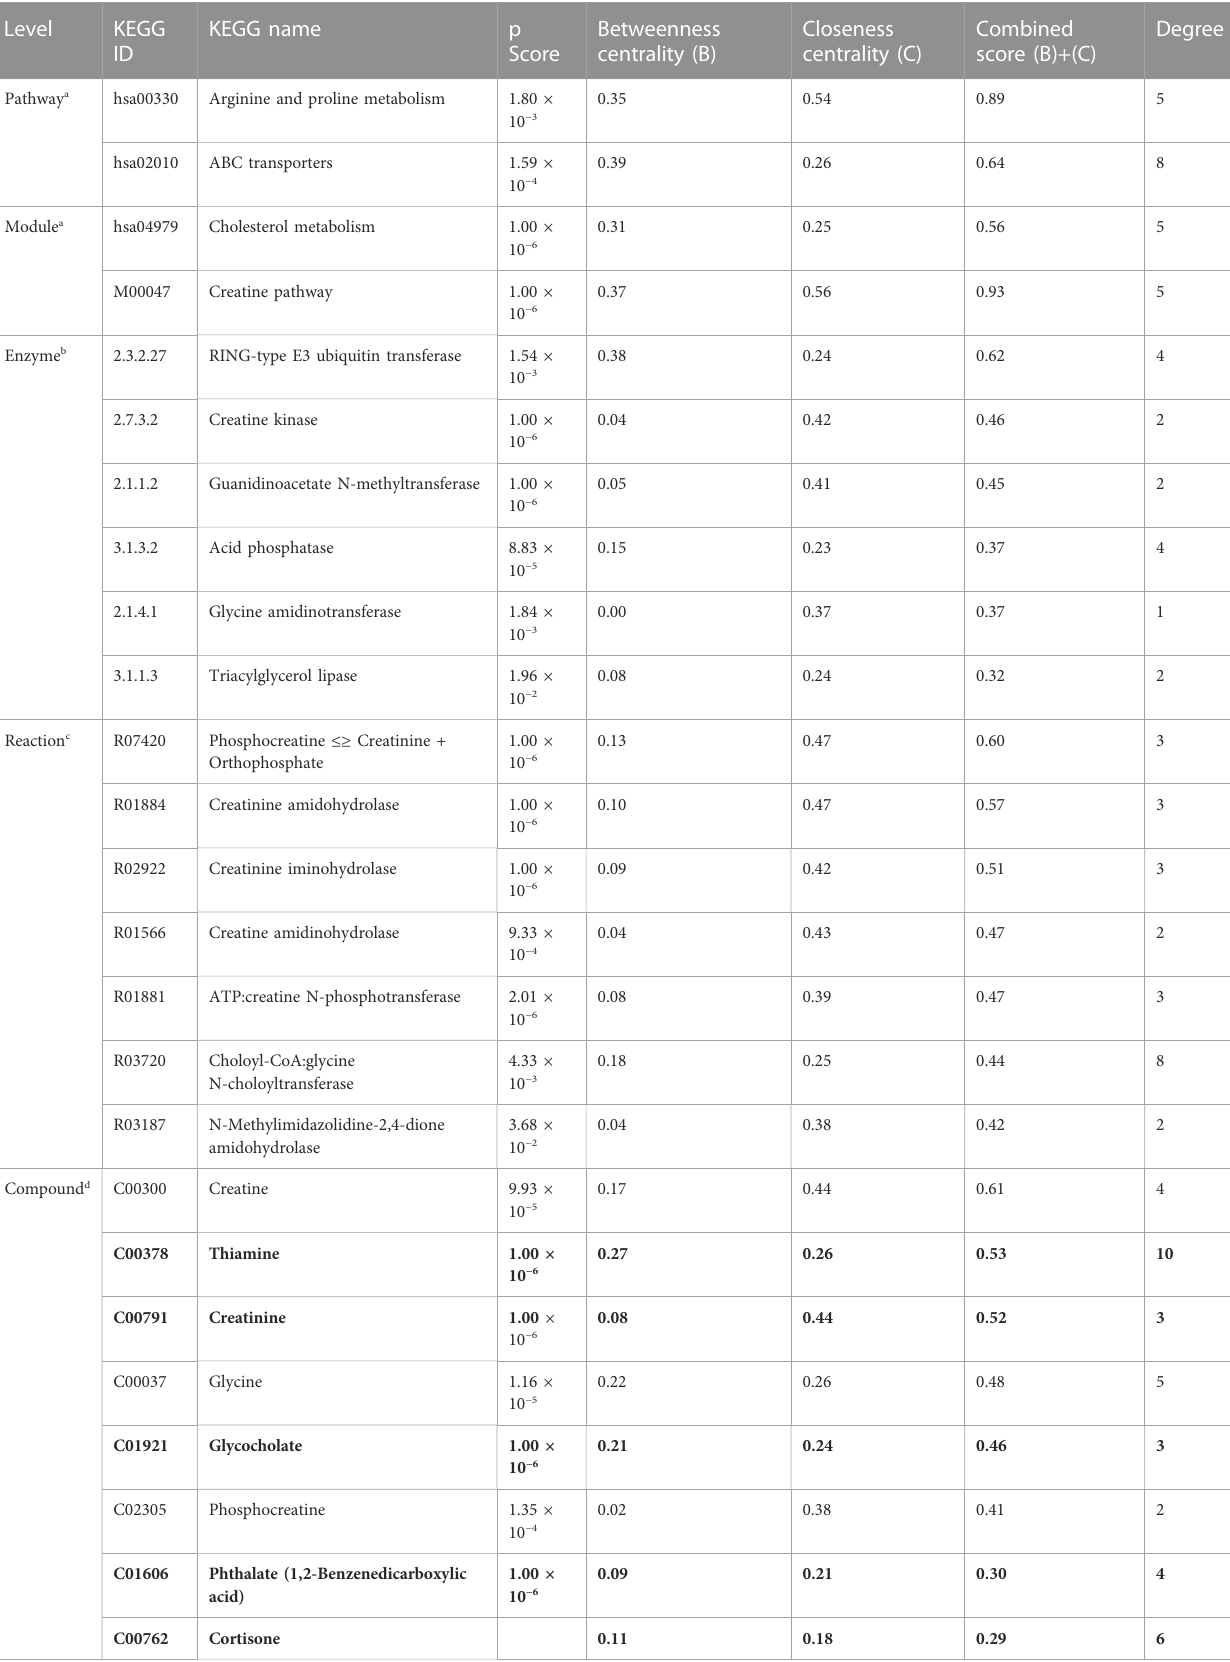
TABLE 1 Summary of topological attributes of the top 5% signi fi cant biological components at each biological level.